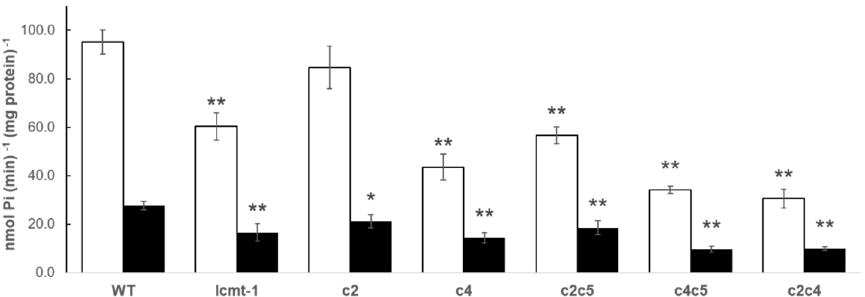
Figure 1. PP2A activity in selected Arabidopsis mutants. Activity was assayed separately in roots (white bars) and shoots (black bars) from 10-d-old seedlings grown on one-half MS medium. SE is given ( n = 3, three biologically independent experiments), two asterisks indicate that values are significantly different from WT according to Student’s t -test with p < 0.05, and for one asterisk with p < 0.1.